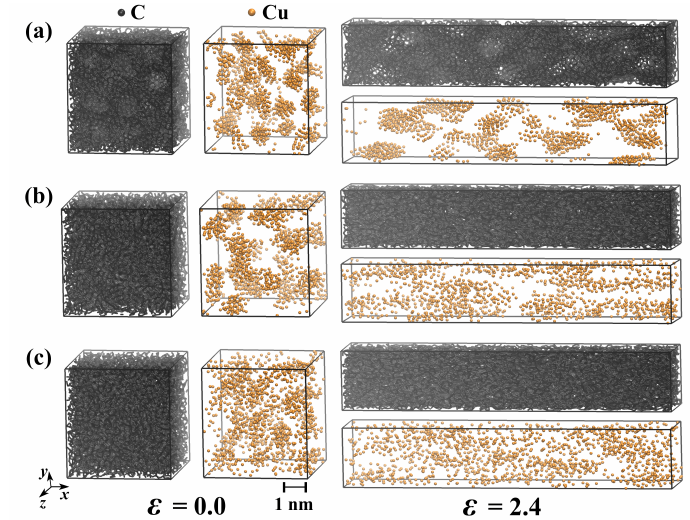
Figure 4. Copper atoms (orange color) and graphene network (black color) are shown separately before and after uniaxial tension: ( a ) BOP; ( b ) EAM-Morse; and ( c ) Morse. Colors as in Figure